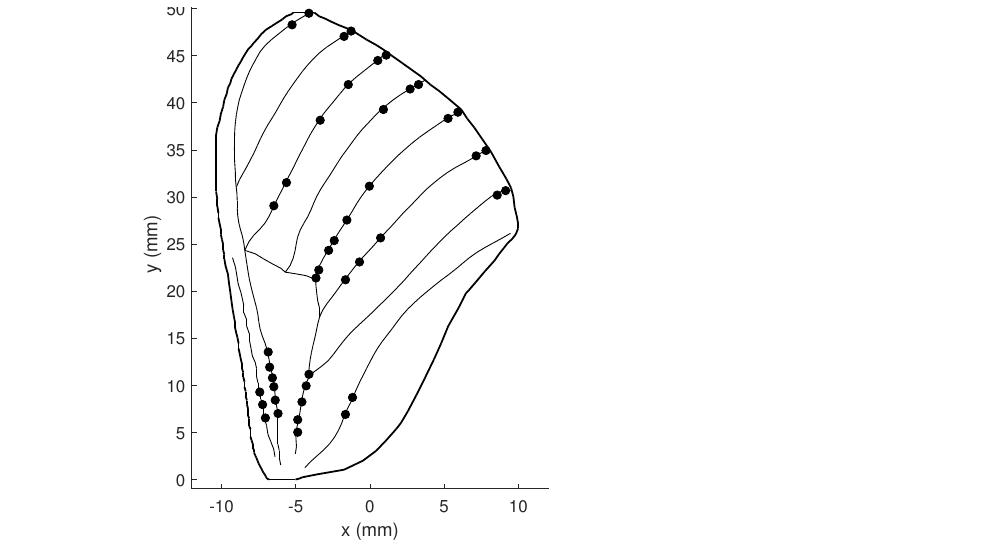
Figure 22. The measured locations of Campaniform Sensilla on the Hawkmoth